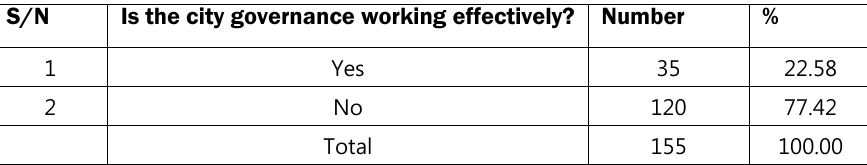
TABLE 4: Citizens’ viewpoint about the effectiveness in the working of city governance S/N Is the city governance working